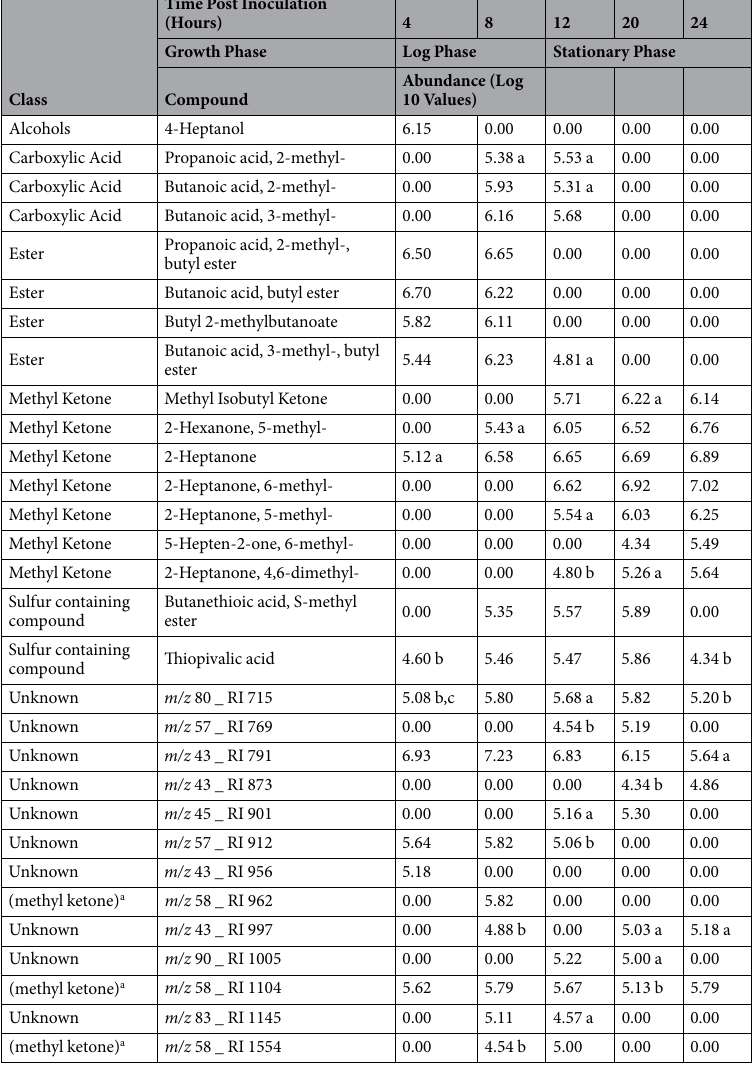
Table 5. Average relative abundances (Log-10 Scale) of B. anthracis Sterne-associated VOC markers at all measured timepoints, separated by growth phase. Notes: a VOC detected in 2/3 of triplicate measurements b VOC detected in 1/3 of triplicate measurements c VOC detected at levels less than 10x abundance in media blank d GC/MS fragmentation similar to observed methyl